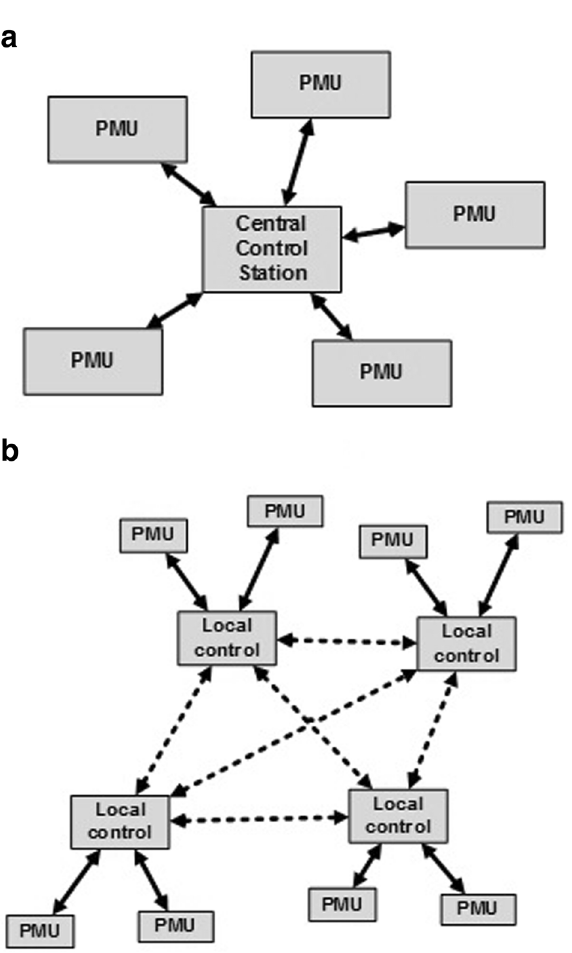
Fig. 14 a Centralized architecture. b Decentralized